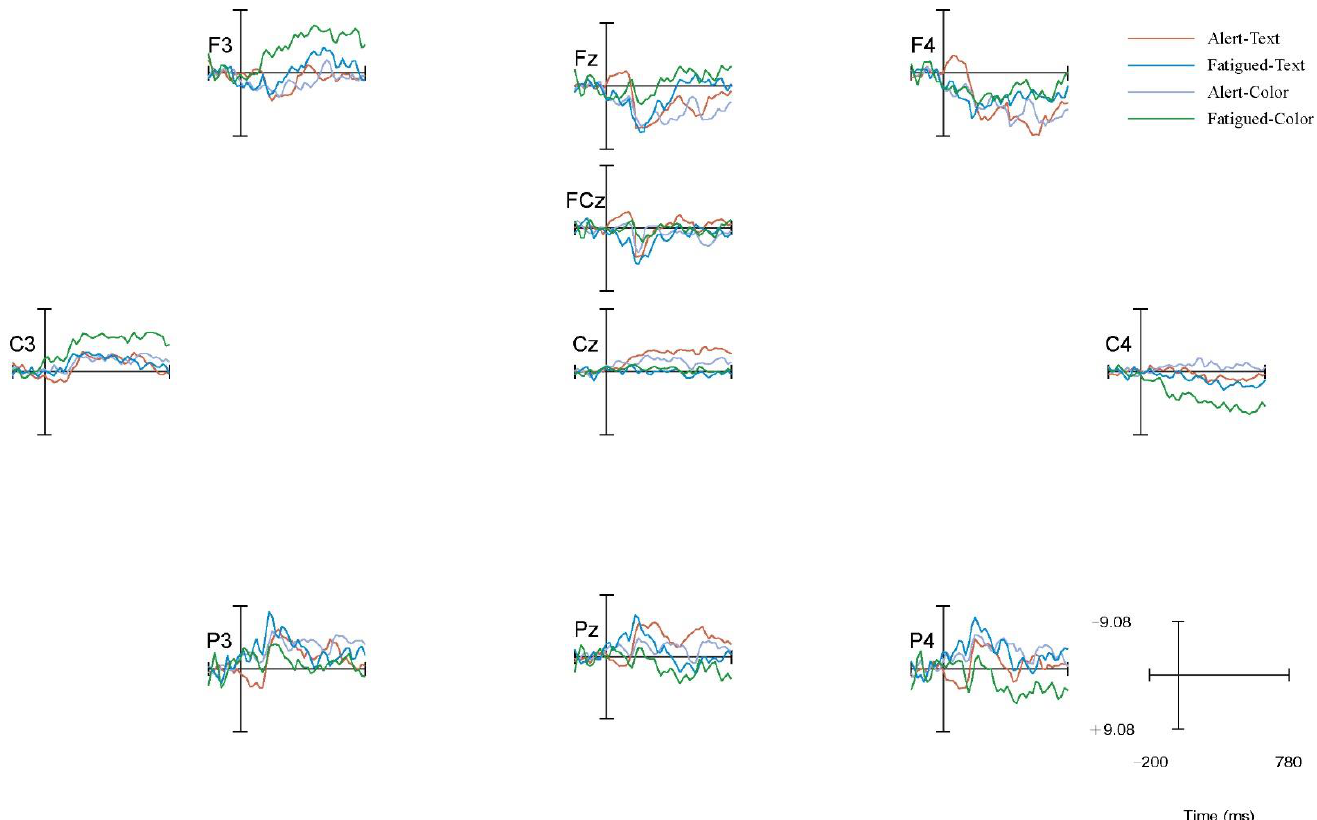
Figure 6. ( a ) Accuracy rate of mental state × visual code. ( b ) Reaction time of mental state × visual code.